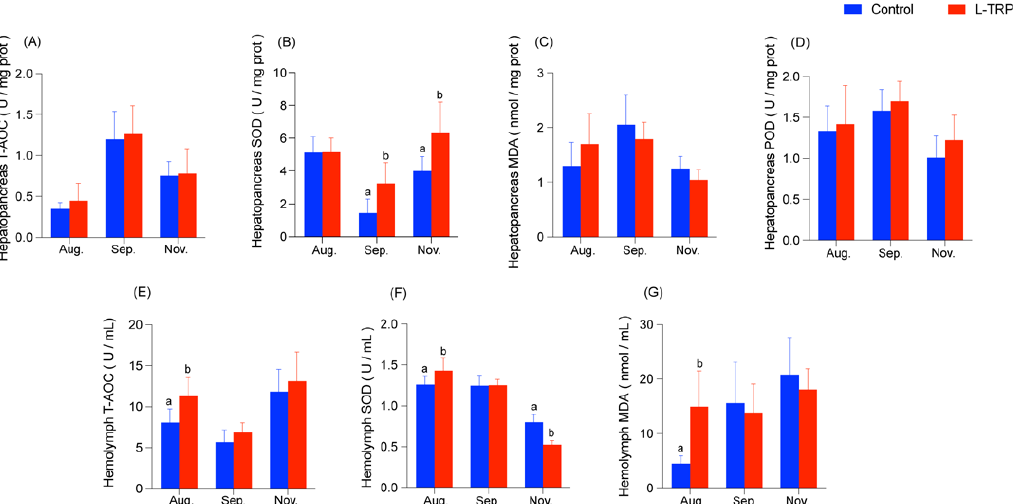
Figure 2. Effects of dietary L-TRP on antioxidant capacity (including T-AOC, SOD and POD) of hepatopancreas ( A – D ) and hemolymph ( E – G ) in E. sinensis . T-AOC: total antioxidant capacity; SOD: superoxide dismutase; MDA: malondialdehyde; POD: peroxidase. The values are expressed as the means ± SD (N = 8). Different letters above the column indicate the significant differences between the control and L-TRP groups ( p < 0.05).